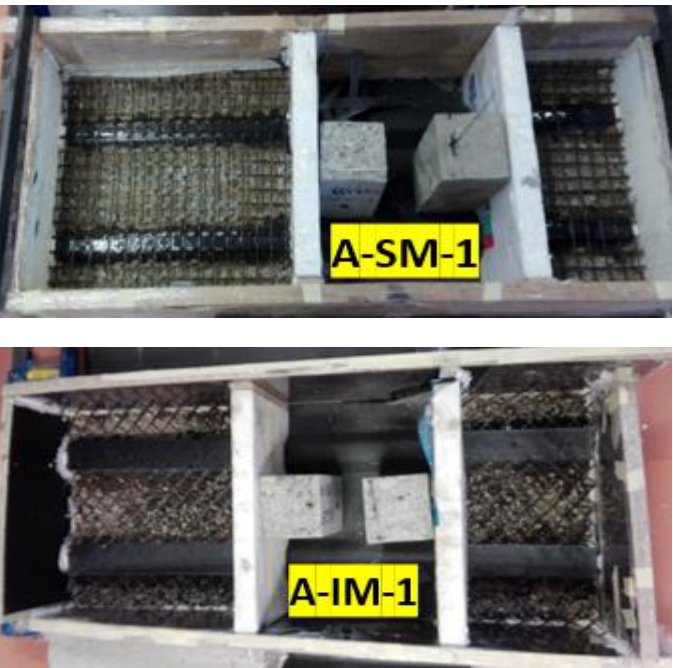
Figure 2. Formwork and CFRP connection of specimens A-SM-1 and A-IM-1 before concrete was poured.